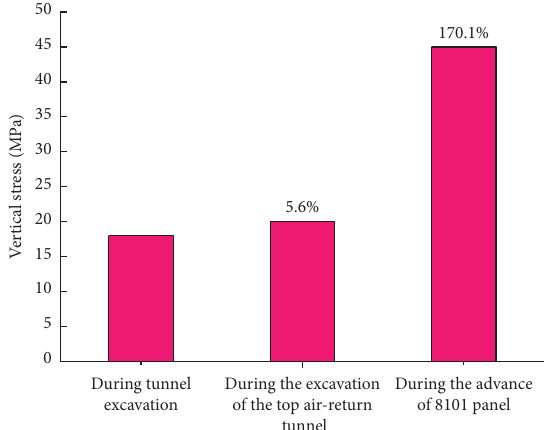
Figure 7: Comparison of roof subsidence of air-return roadway 5103 in different mining